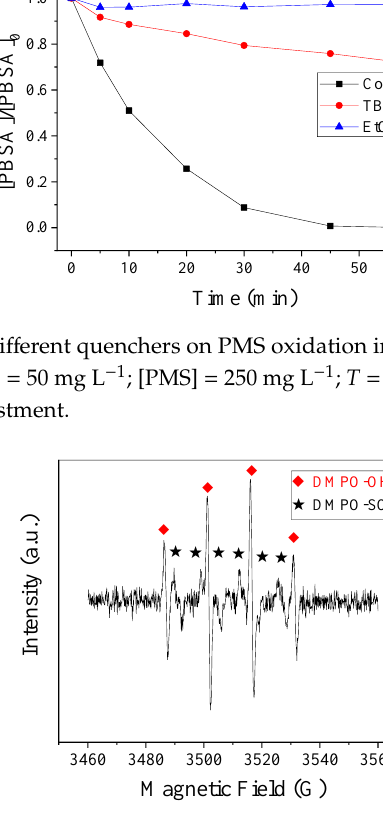
Figure 8. Electron paramagnetic resonance (EPR) spectra of the 5,5-dimethy-1-pyrroline (DMPO) adduct (DMPO–OH and DMPO–SO 4 ) formed after five min in the CoMn 2 O 4 /PMS system. Conditions: [catalyst] = 50 mg L −1 ; [PMS] = 250 mg L −1 ; T = 25 °C; [DMPO] = 20 mM.